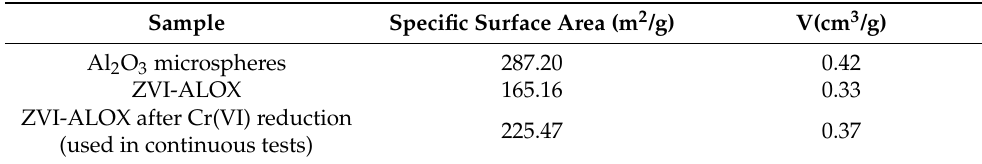
Table 1. Specific surface areas and total pore volumes (BET method).